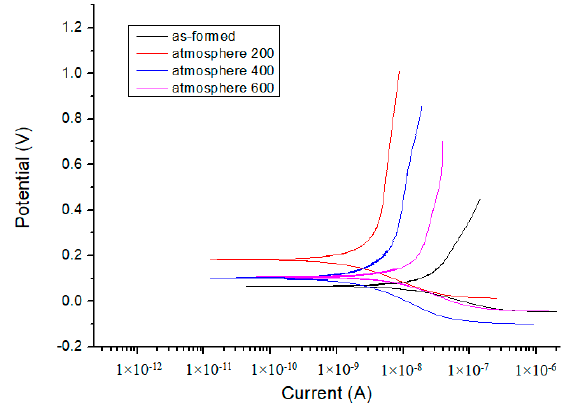
Figure 14. The corrosion behaviors of the anodized and annealed samples in the atmosphere.